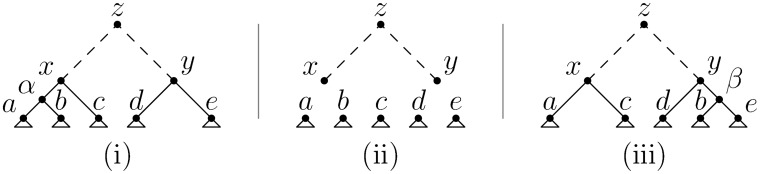
A prune and regraft not involving the root requires three records.(i) We begin with two subtrees rooted at x and y, and we wish to prune the subtree rooted at b and graft it in the branch joining e to y. (ii) We remove the assignments (a, b) → α, (α, c) → x and (d, e) → y. After this operation, the subtrees a, …, e are disconnected from the main tree. The main trunk the tree rooted at z is unaffected, as are the subtrees below a, …, e. (iii) We add the records (a, c) → x, (b, e) → β and (d, β) → y, completing the transition.